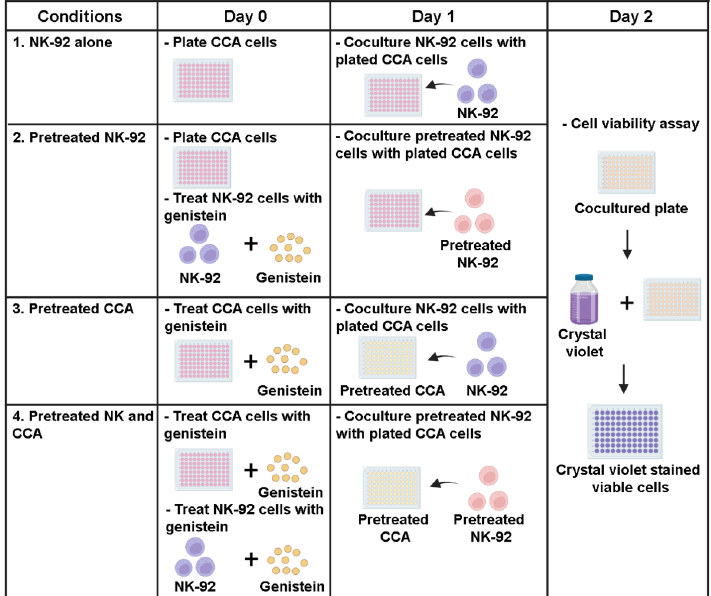
Figure 1. Sensitization effects of genistein on CCA cells to be killed by NK-92 cells in killing assay. The experiments were divided into 4 conditions: (1) NK-92 alone condition, CCA cells (target cells) and NK-92 cells (effector cells) were cocultured without the addition of genistein (control group), (2) Pretreated NK-92 condition, NK-92 cells were treated with 50 µM of genistein for 24 h prior to coculture with CCA cell lines, (3) Pretreated CCA condition, CCA cells were treated with 50 µM of genistein for 24 h prior to coculture with NK cells. (4) Combination of pretreated NK and CCA condition, NK cells and CCA cell lines were treated with 50 µM of genistein for 24 h and used in killing assay. In the killing assay, the E:T ratio was 1:1. The viable cells were measured after 24 h of coculture.